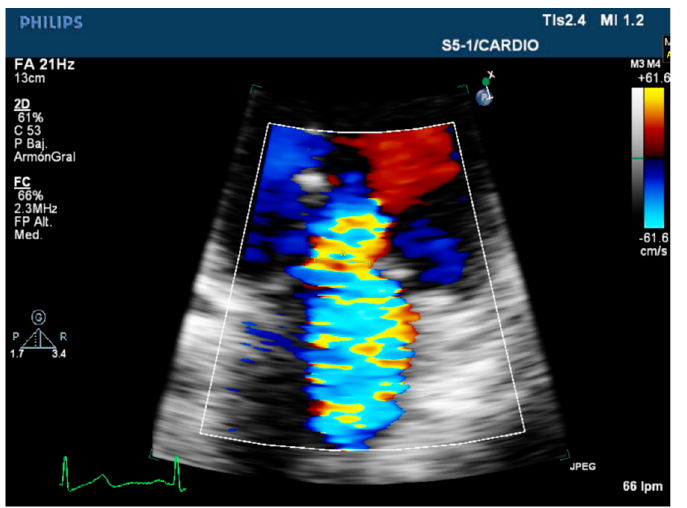
Figure 1. Transthoracic echocardiography. Vena contracta in severe mitral regurgitation.